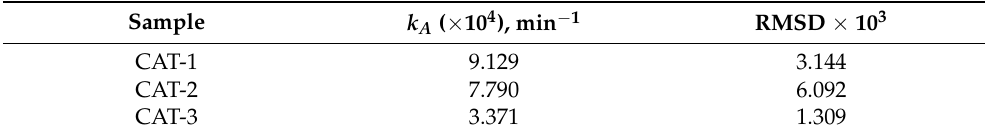
Figure 7. Pseudo-first-order kinetic curves of the imidacloprid photodegradation. Table 1. Estimated values of the reaction rate constant ( k A ) and the corresponding root mean square deviations (RMSD) for the kinetic model of